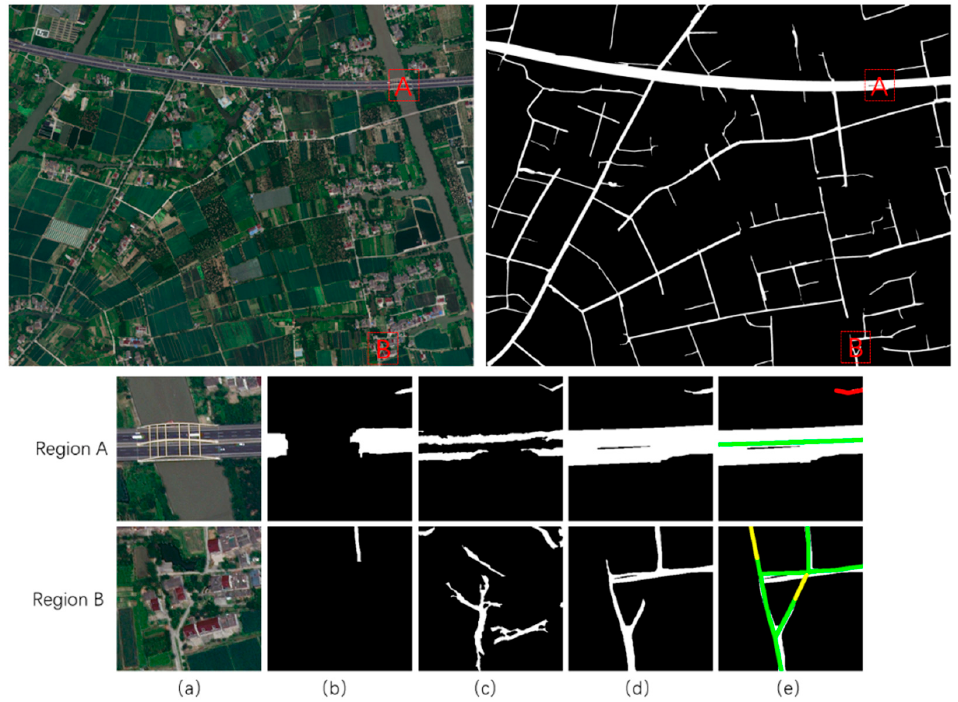
Figure 24. Tested data Area 2. Optical and SAR remote sensing images and road extraction results in the Chongzhou area. ( a ) Worldview-2 optical remote sensing image; ( b ) TerraSAR-X remote sens- ing image; ( c ) road extraction results of optical remote sensing image; ( d ) road extraction results from SAR remote sensing images; ( e ) road fusion extraction results of optical and SAR images; ( f ) ground truth and marking results of road fusion extraction results (green refers to the correctly ex- tracted road, red refers to the incorrectly extracted road, and yellow refers to the omitted real road).